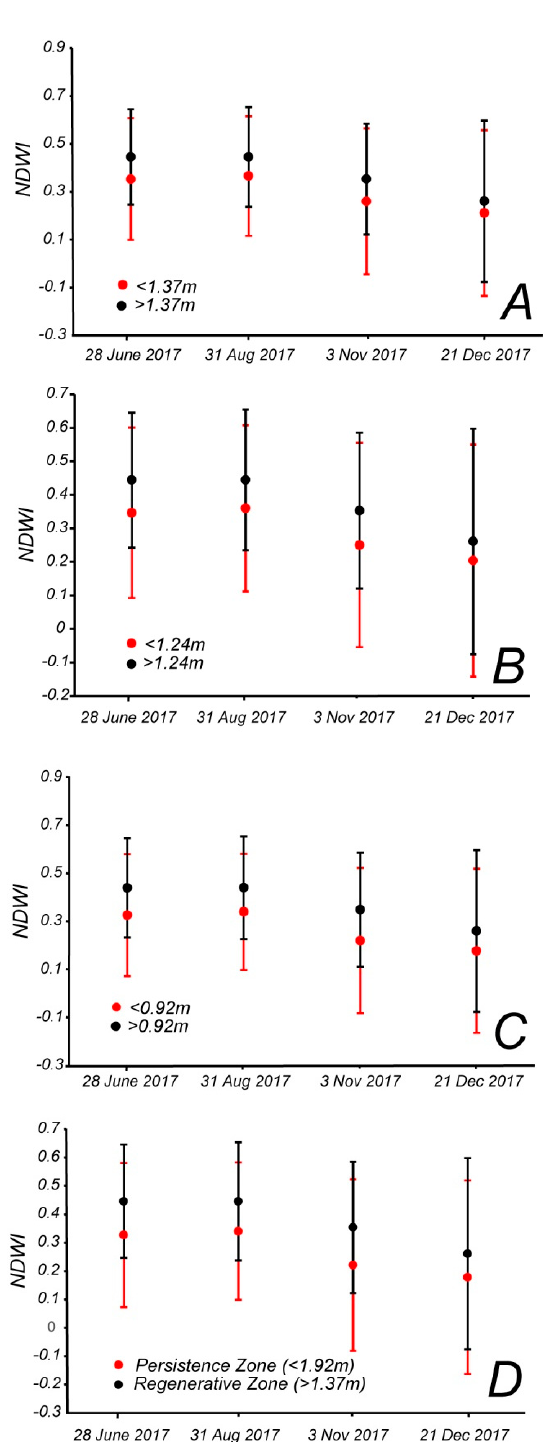
Figure 6. ( A ) Comparison of average NDWI for elevations below and above 1.37 m for four Landsat images in di ff erent seasons. ( B ) Comparison for elevations below and above 1.24 m. ( C ) Comparison for elevations below and above 0.93 m. ( D ) Average NDWI in the persistence zone (below 0.93 m) compared to average NDWI in the regenerative zone (above 1.37 m). Bars represent two standard deviations. The average NDVI of the area above each elevation boundary is consistently higher than below the boundary, at all three elevations. The zones based on the 0.92 m boundary show a larger di ff erence between average NDVI values, and the upper zone shows a larger drop moving from June to the end of August (Figure 5C). The zones based on the average sapling elevation of 1.24 m show a